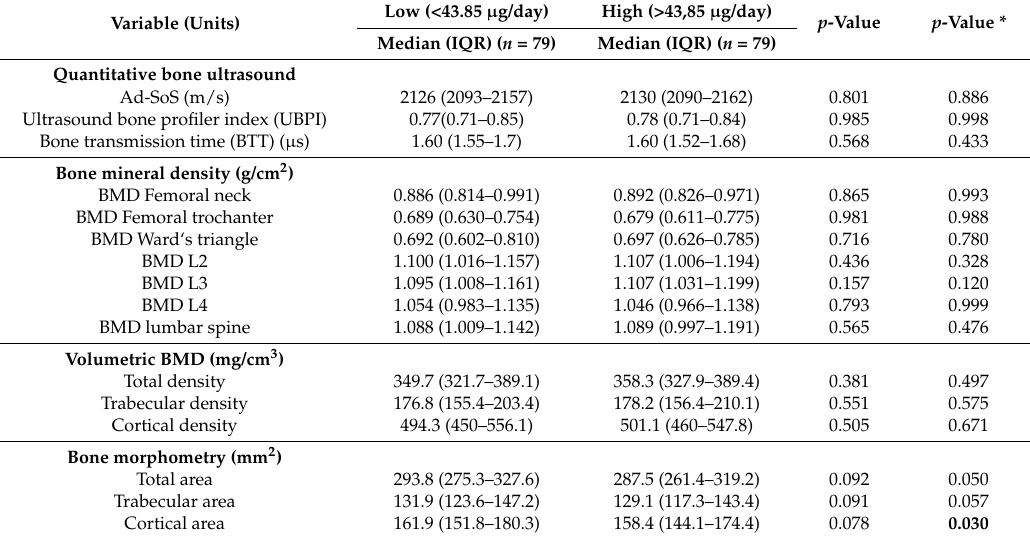
Table 5. Bone density and lead dietary intake in premenopausal women. Variable